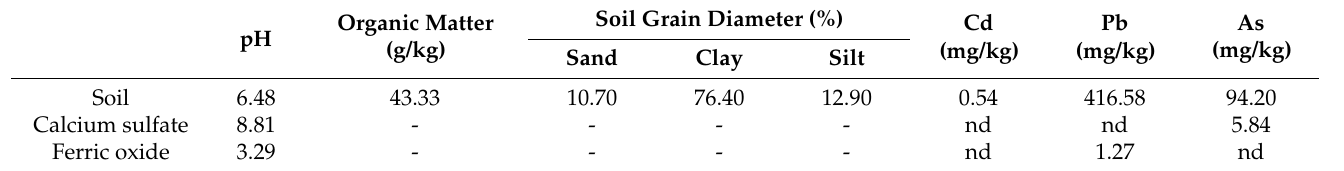
Table 1. Basic physical and chemical characteristics of the tested soil and CSF.